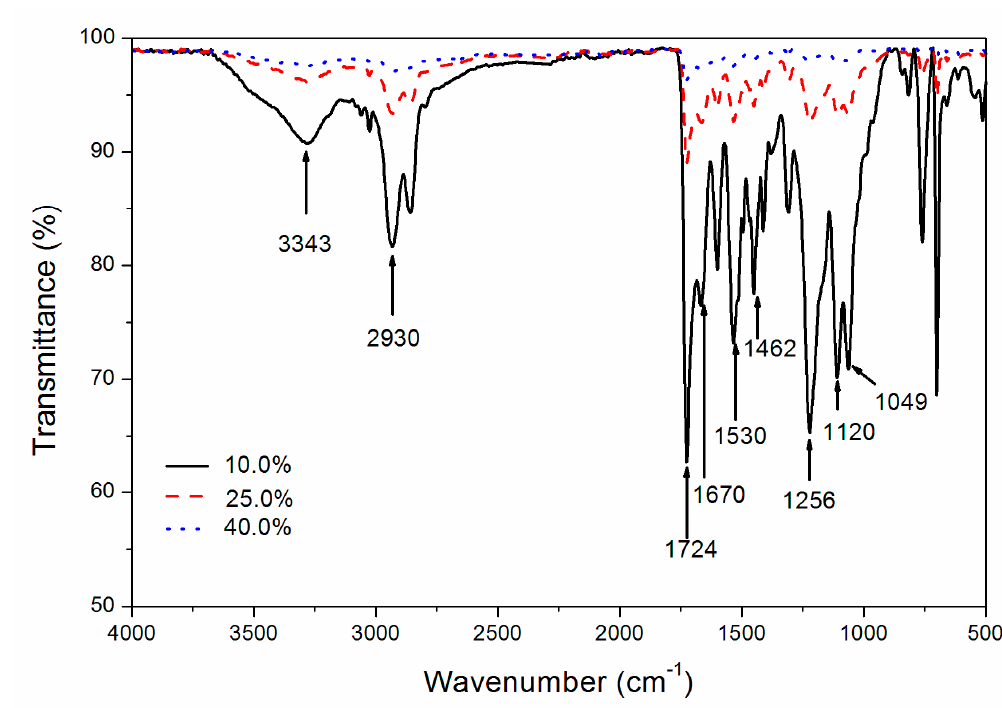
Figure 4. Influence of the Al powder concentration on the infrared spectrum. Table 7. Assignment of the bands.